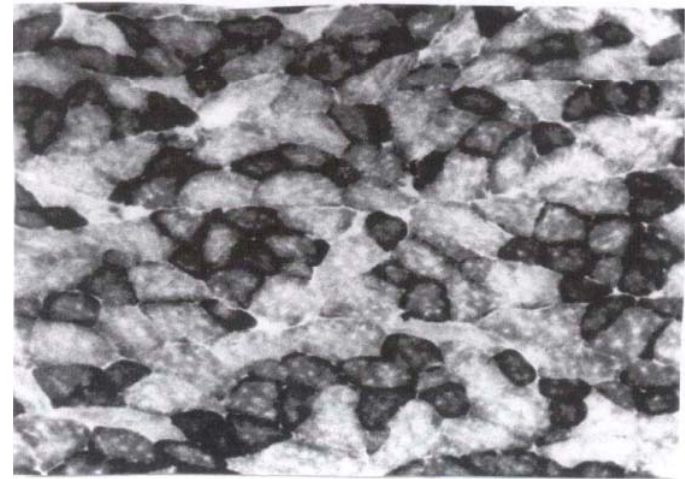
Figure 2. SDH stain, plantaris muscle, 24-month old